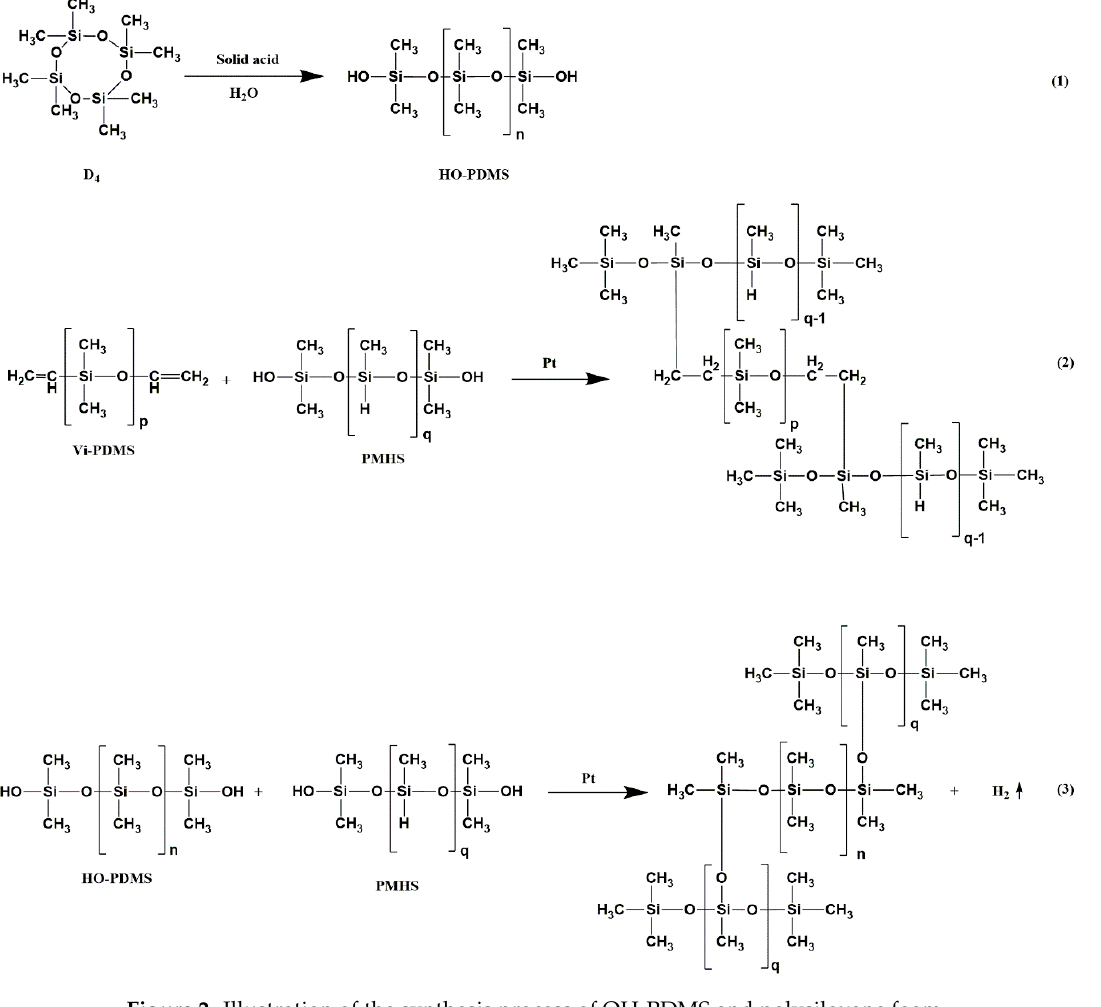
Figure 2. Illustration of the synthesis process of OH-PDMS and polysiloxane foam.